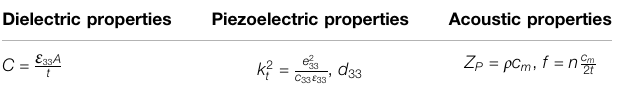
TABLE 2 | Material parameters of transducer